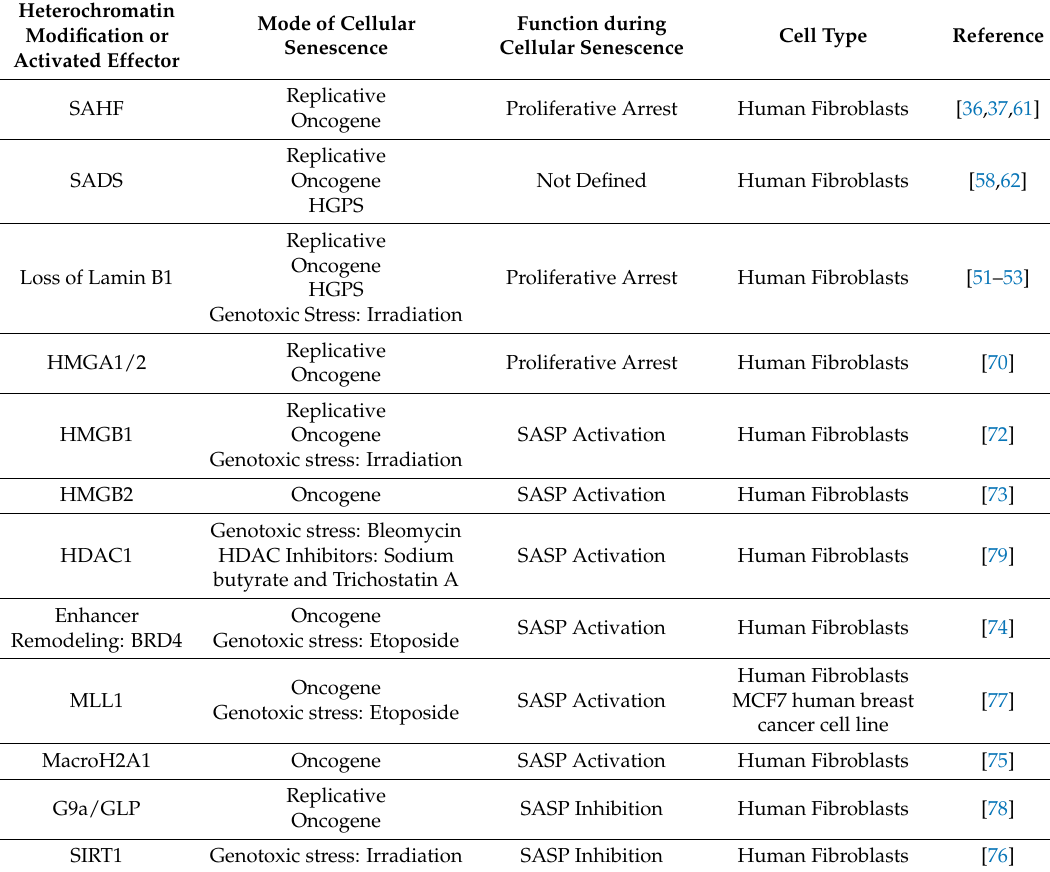
Table 1. Epigenetic changes and effectors of cellular